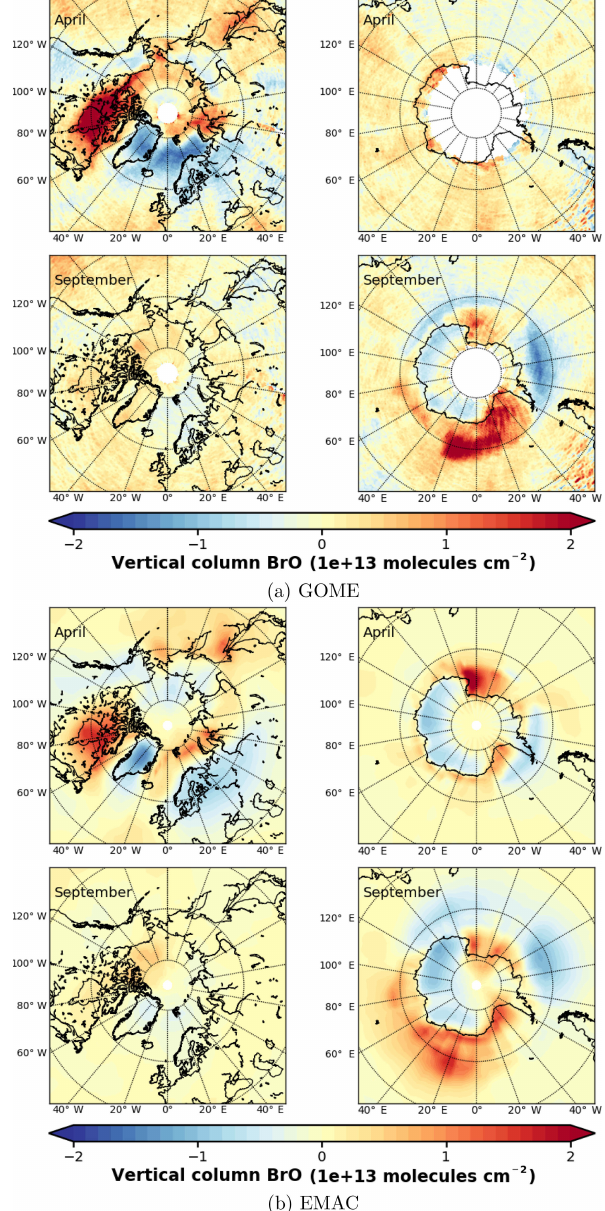
Figure 4. Anomalies of monthly mean VCD of BrO for the Arctic and Antarctic (April and September) with respect to monthly aver- aged zonal mean (see Sect. S4), respectively. EMAC data have been sampled in accordance at 10:00–11:00LST. (a) GOME; (b) EMAC